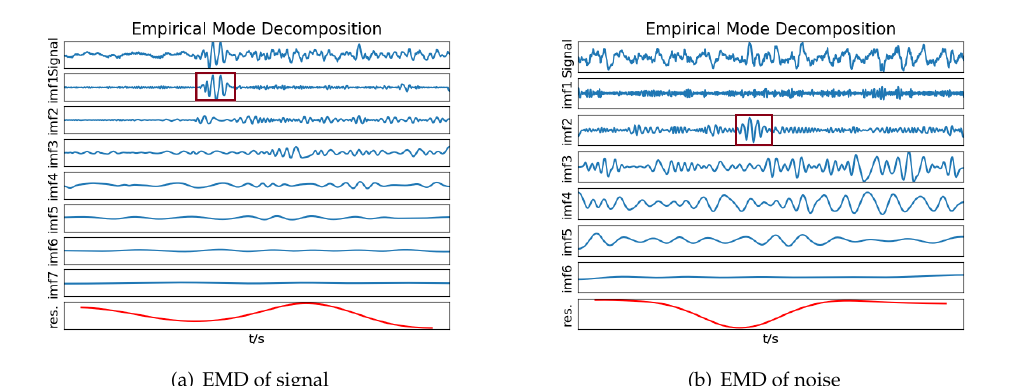
Figure 3. The empirical mode decomposition (EMD) diagram of signal and noise. In the subgraphs ( a , b ), the top curve is the original signal, and others are intrinsic modal components with the frequency decrement from high to low. The intrinsic mode function 1 (IMF1) of seismic is the main component compared to the IMF1 of